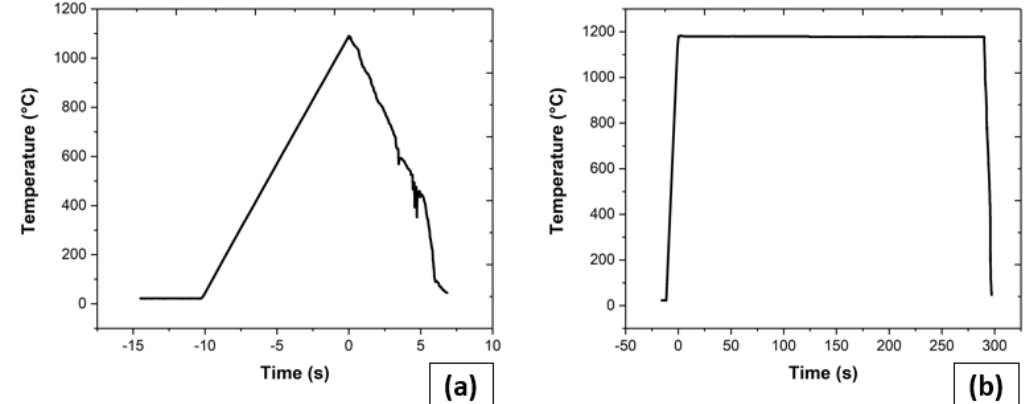
Figure 2. Final annealing treatments carried out on a Gleeble 3500 to obtain modified annealed microstructures at ( a ) 1100 °C for 0 s (MAM1) and at ( b ) 1180 °C for 300 s (MAM2).